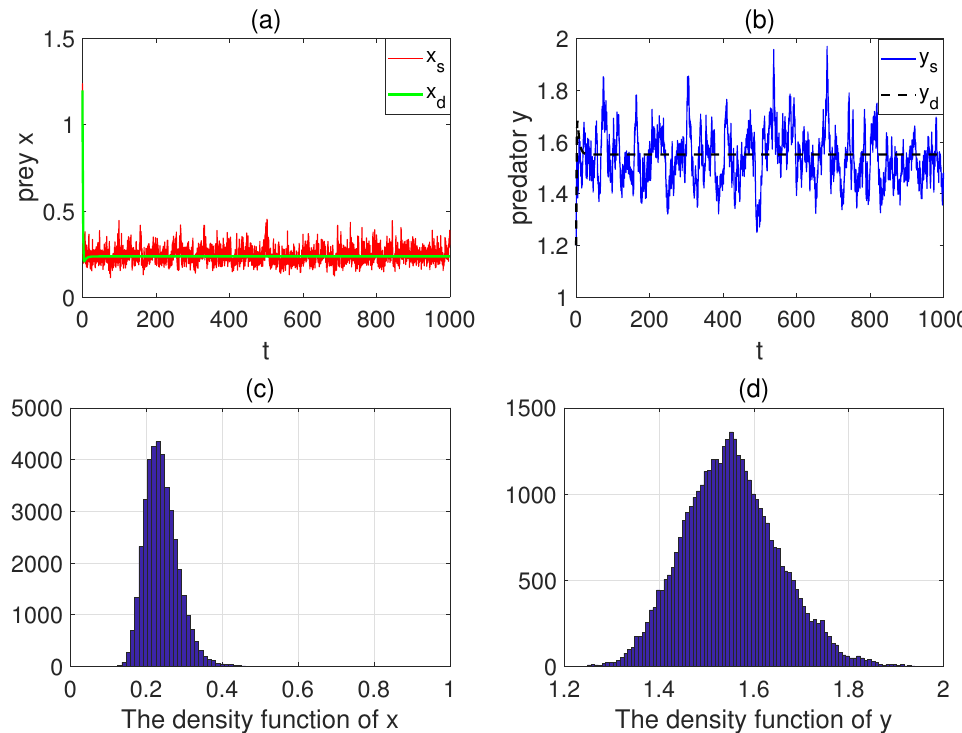
Figure 3. ( a , b ) The persistence of model ( 2 ) with β = 0.8. ( c , d ) The probability density functions of x ( t ) and y ( t ) of model ( 2 ) with β = 0.8.